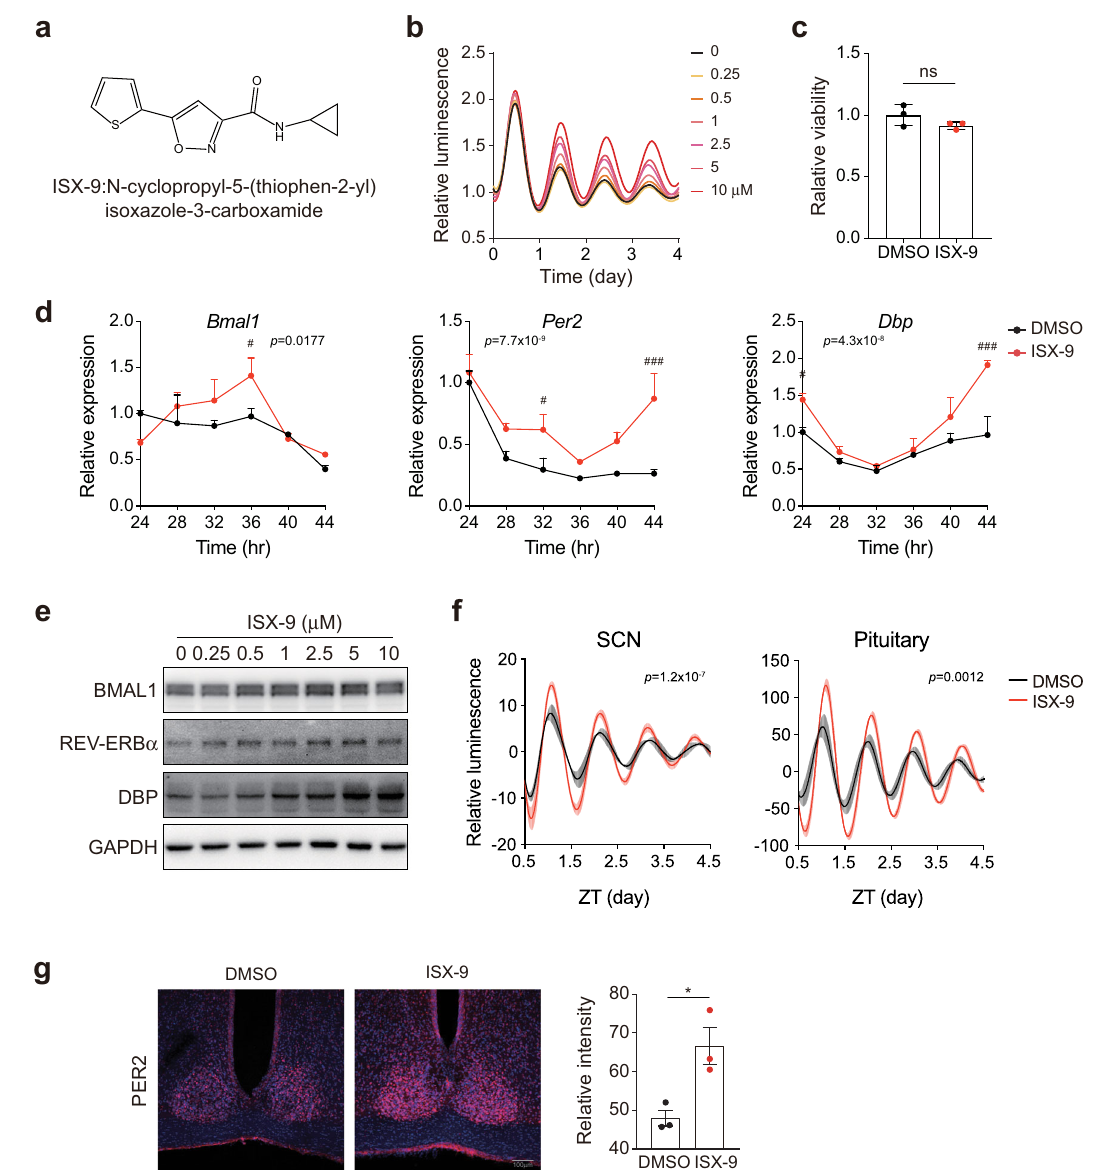
Fig. 2 ISX-9 enhanced circadian amplitudes in culture cells and tissues. a Chemical structure of ISX-9. b Dose-dependent effects of ISX-9 in the mPer2 Luc MEFs. c Viability test of ISX-9 in MEF cells for 72 h. Unpaired Student ’ s t -test was used (ns not signi fi cant). d Quantitative PCR analyses of clock gene expressions in MEFs treated with vehicle or ISX-9 at different zeitgeber time points. Two-way ANOVA with Bonferroni correction for multiple comparison was performed, with p value labeled on top. Signi fi cances between DMSO and ISX-9-treated cells in each time point were shown (# p < 0.05 and ### p < 0.001), and data were shown as mean ± SD. e Immunoblots for BMAL1, REV-ERB α , and DBP levels upon increasing doses of ISX-9 treatment. f ISX- 9 (10 μ M) enhances PER2::LUC rhythms in SCN explants and pituitary from mPer2 Luc mice. Two-way ANOVA with Bonferroni correction for multiple comparison was performed with p value indicated on top, and data are shown as mean ± SEM. g Immunohistochemistry of PER2 level in the SCN from 6-month-old mice treated with DMSO or ISX-9 (20 mg/Kg) for 7 days. Quanti fi cation of the PER2 levels were shown (right), as mean ± SEM. Unpaired Student ’ s t -test was used (* p <